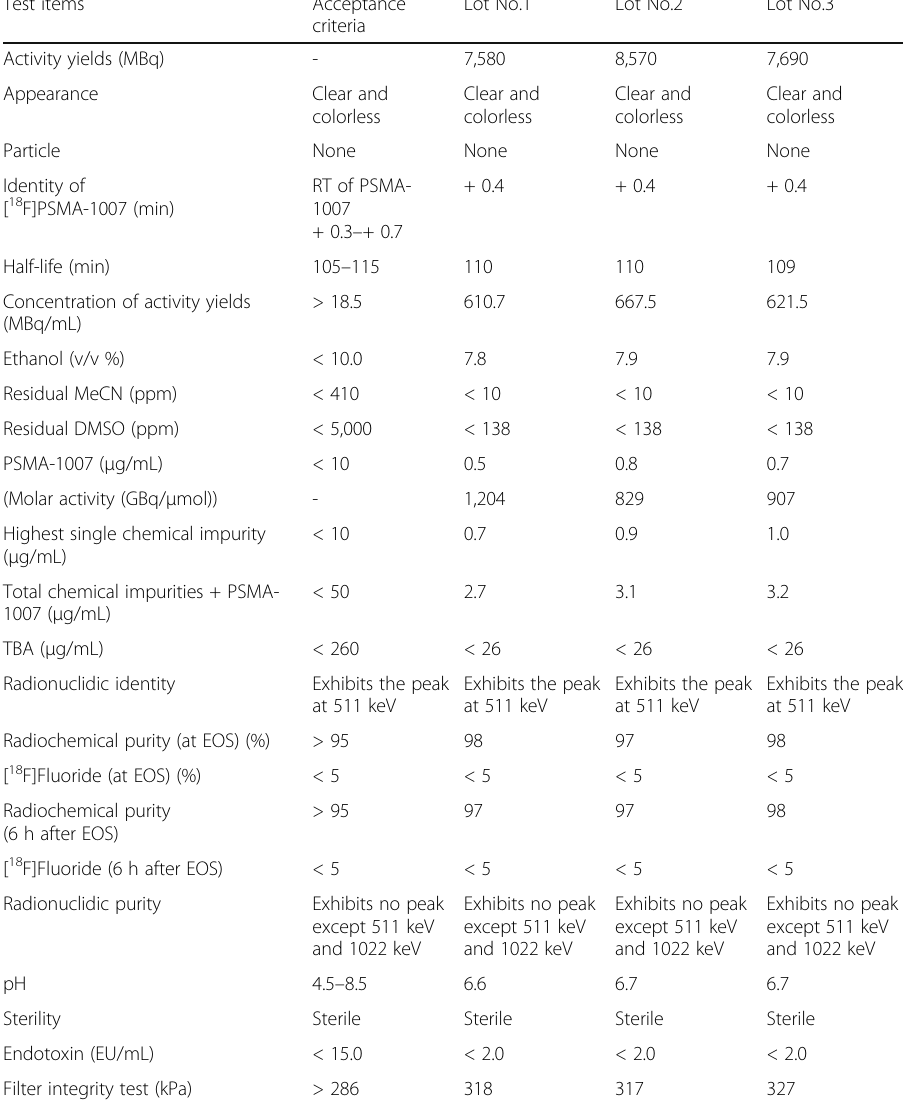
Table 3 Results of synthesis and quality control tests for [ 18 F]PSMA-1007 injection